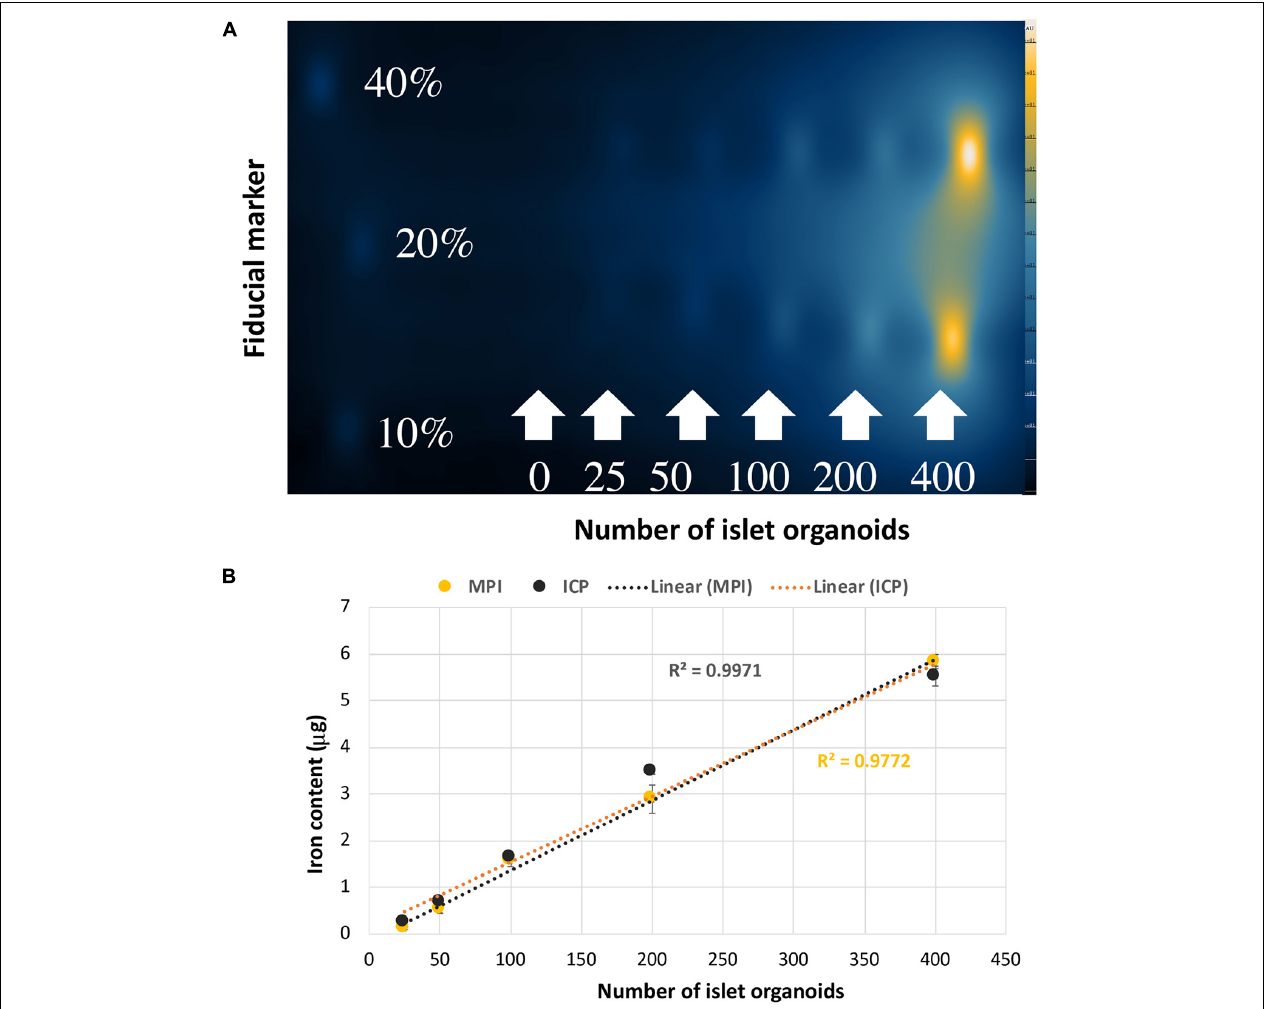
FIGURE 4 | Islet organoids phantoms imaging and iron content quantification. (A) MPI of the different number of SPIO labeling islet organoids phantom. (B) Iron content of the islet organoids phantoms measured by MPI ( R 2 = 0.9971) and ICP-OES ( R 2 = 0.9772) both correlated with the number of labeled islet organoids. Data are represented as mean ±